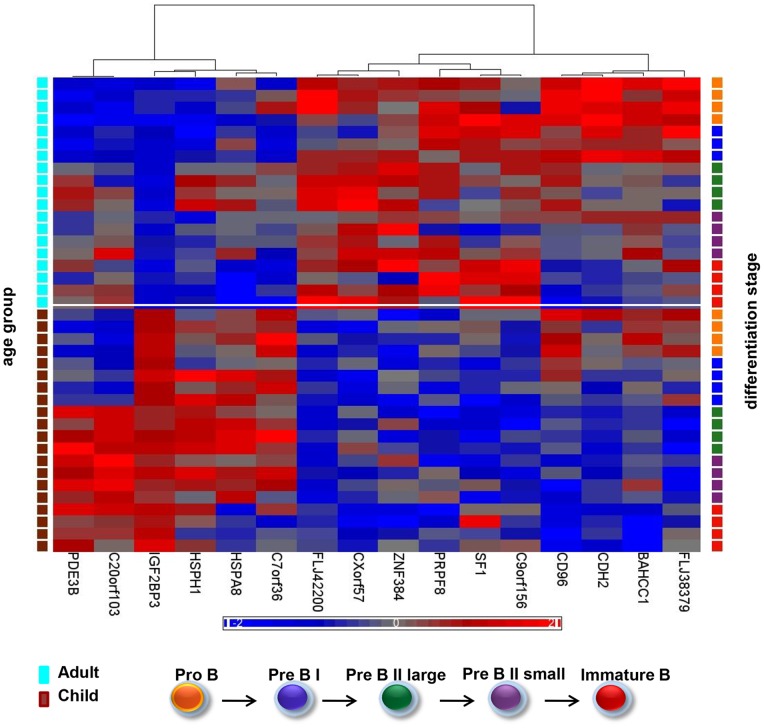
Age-related alterations in gene expression in precursor B cells.Heatmap based on hierarchical clustering of the16 most differentially expressed mRNAs common to all stage comparisons in children versus adults (FDR1%, p≤1.13×10−05). Six transcripts were higher expressed in all pediatric precursor B cell subsets and ten were generally over-expressed in adults. The color codes indicating differentiation stage (right) and age group (left) are explained below.